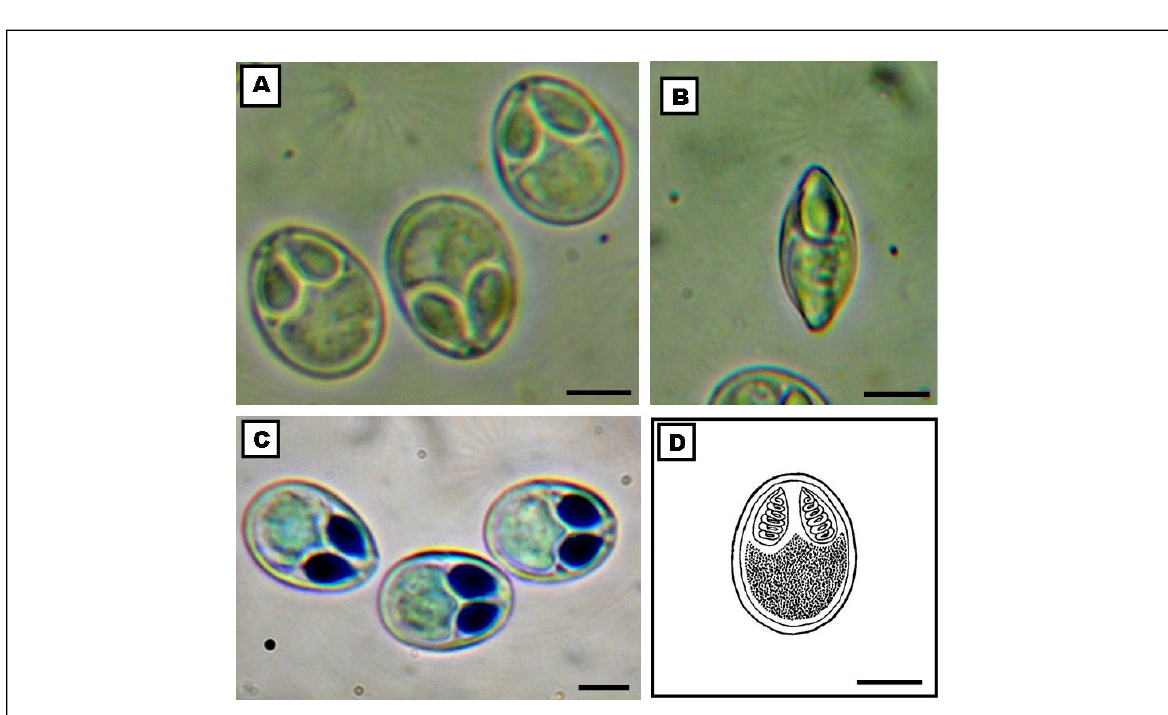
Figure 4: Microphotographs of Myxobolus dzeufieti sp. nov. (A-C): unstained spores in frontal view ( A ); unstained spore in lateral view ( B ); stained spores with May-Grünwald-Giemsa ( C ). Line drawing of the mature spore (D). Scale bar: 5 µ